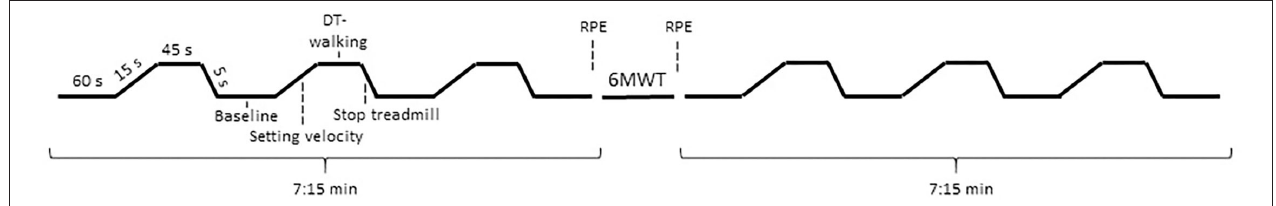
FIGURE 1 | Experimental protocol. DT-walking, dual-task walking; 6MWT, 6-min walk test; RPE, rating of perceived exhaustion.